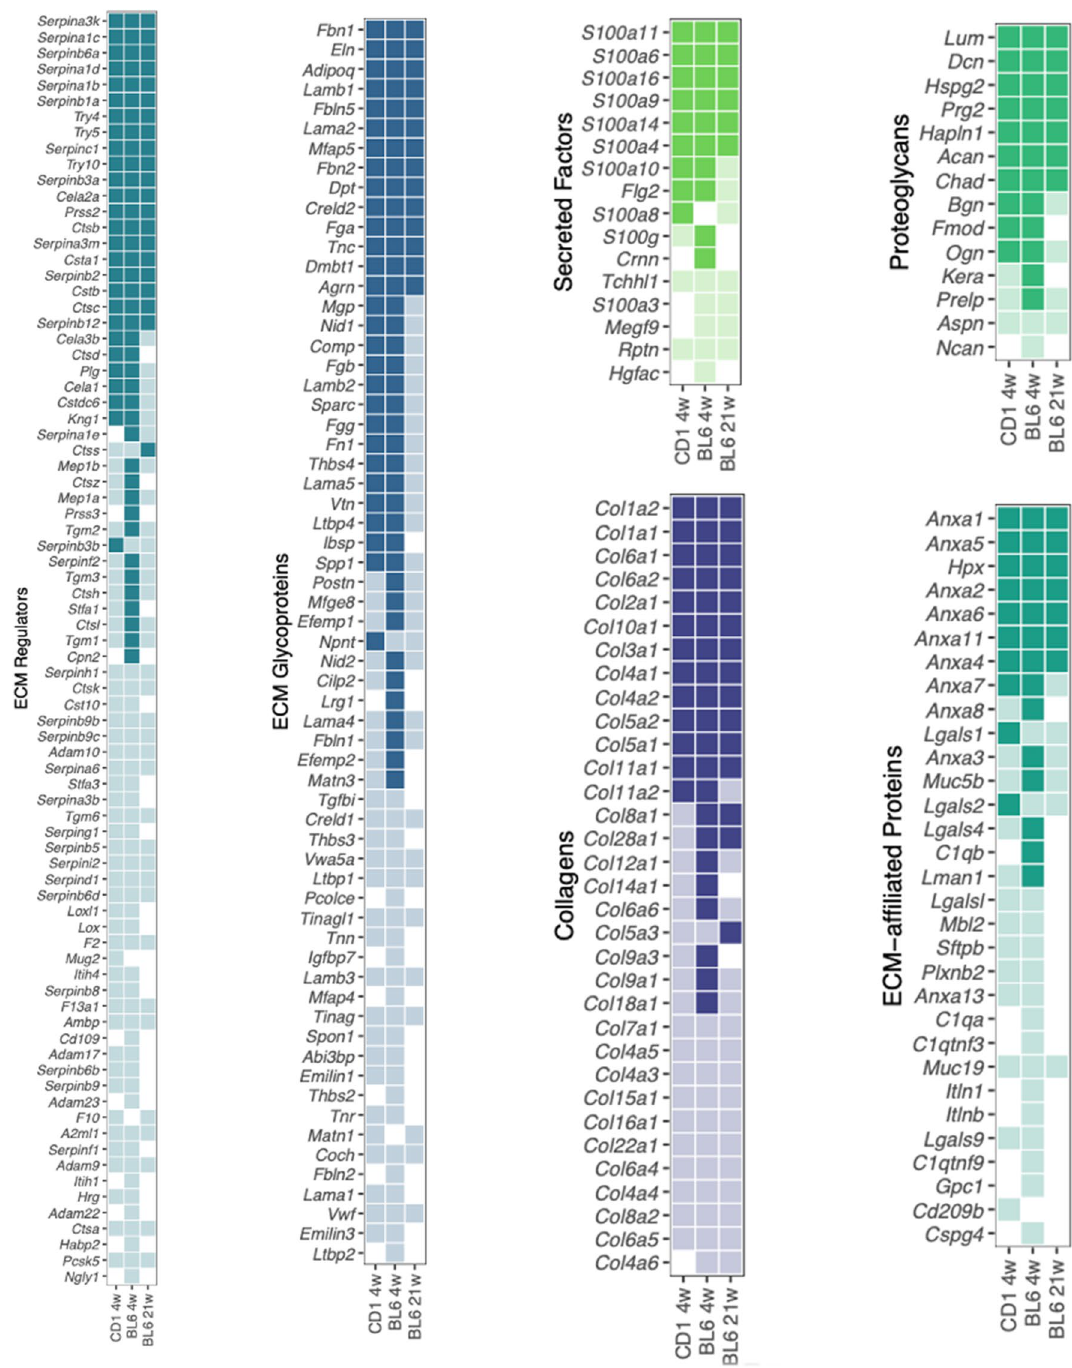
Figure 4. Matreotpype atlas of the wild-type murine proteome. Comparative analysis of all matrisome proteins which could be quantified in at least one of the three animal cohorts: wild-type CD1 (4 weeks) and C57BL/6 at 4 and 21 weeks old. Solid squares represent proteins that were observed to be abundant (> median) in the respective cohort, transparent squares indicate low abundance (≤ median), and white squares highlight non- observable protein-cohort combinations. Details are in Supplementary Table